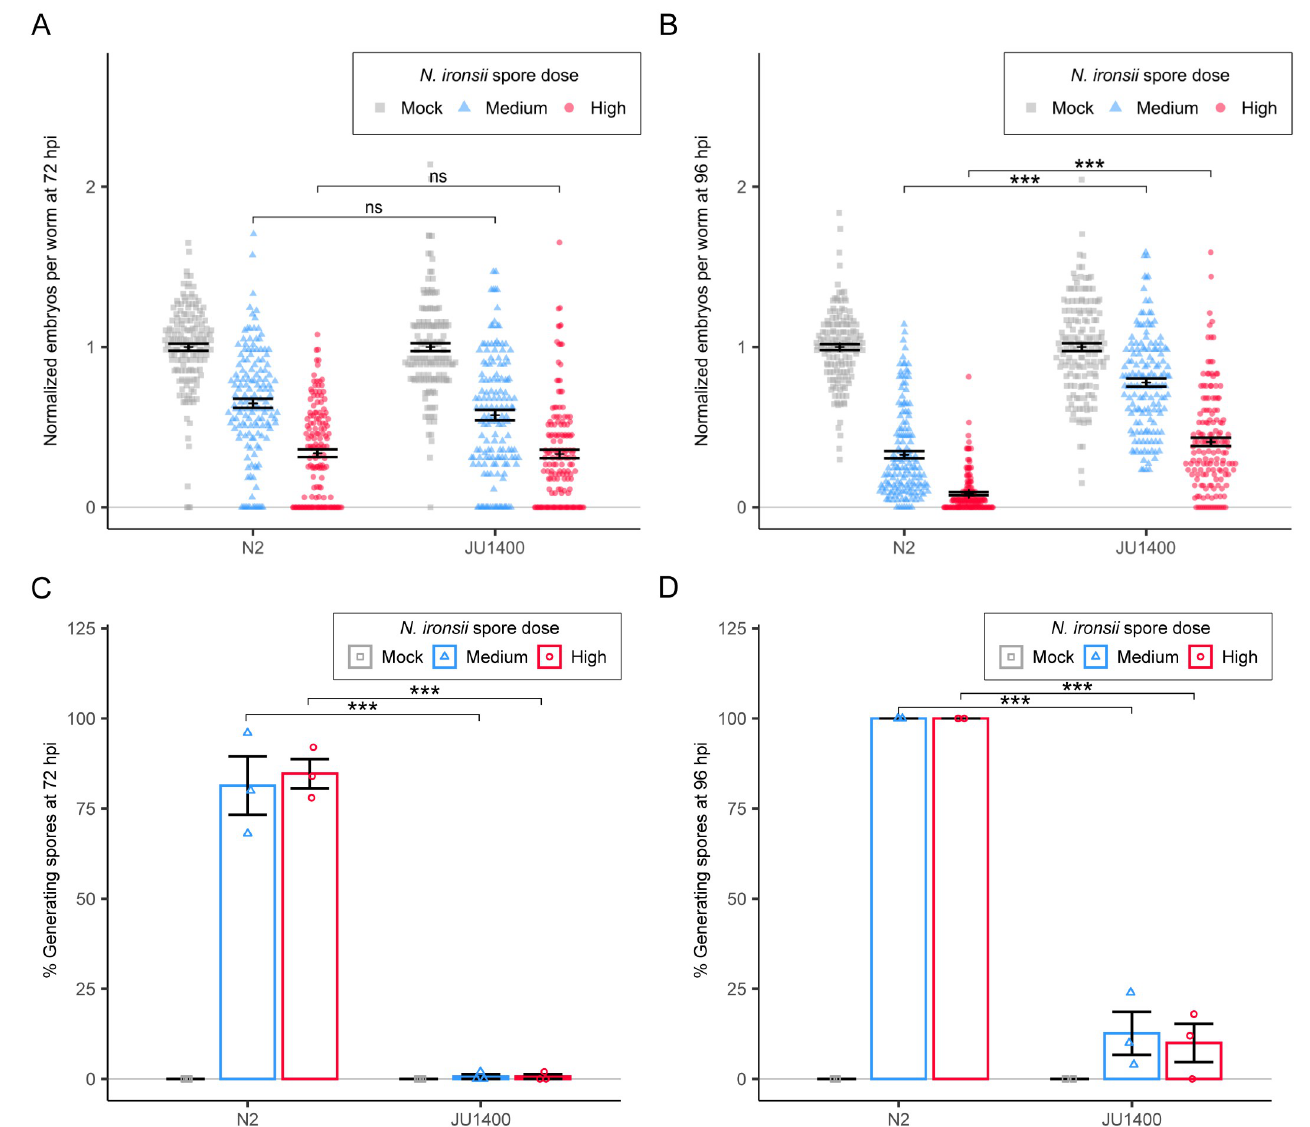
Fig 4. JU1400 is resistant to N . ironsii infection. (A-D) N2 and JU1400 were infected with N . ironsii for 72 hours (A and C) or 96 hours (B and D), fixed, and stained with DY96. (A-B) Dot plots of normalized embryo counts of animals fixed and stained with DY96 with mean and SEM bars. Data is combined from three biological replicates with n = {47,50} worms per replicate sample. (C-D) Bar plot with SEM bars of percent population with new spore formation from three combined replicate experiments. p-values were determined by two-way ANOVA with Tukey post-hoc. Significance was defined as p � 0.001 ( ��� ) and not significant as p > 0.05